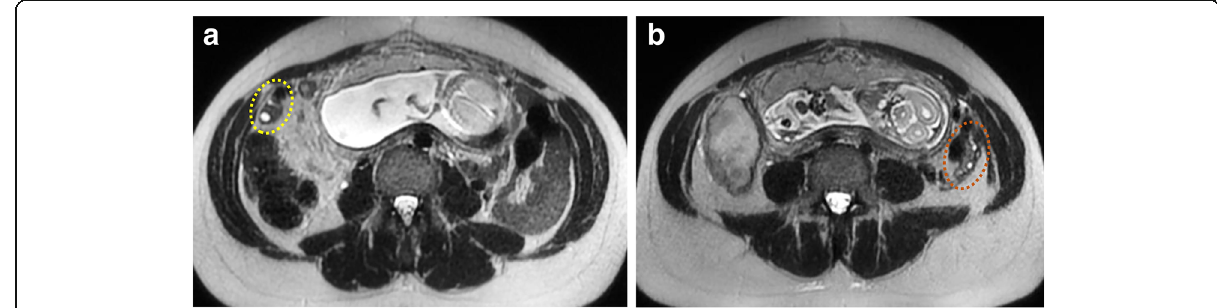
Fig. 2 Both ovaries are identified on axial T2-weighted images (right — yellow ellipse in a ; left — orange ellipse in b )